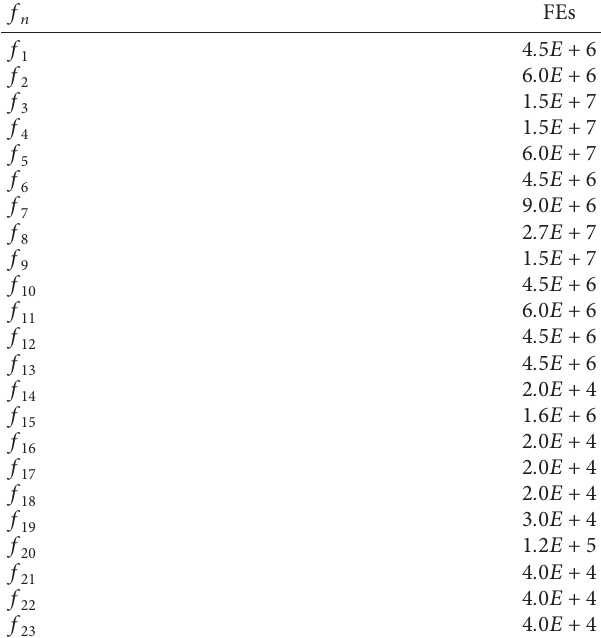
Table 6: Function evaluations of SSMSEP, SSMSEP-1, SSMSEP-2, SSEP, CEP, FEP, and LEP with α � ( 1 . 2 , 1 . 4 , 1 . 6 , 1 . 8 ) on f f n FEs